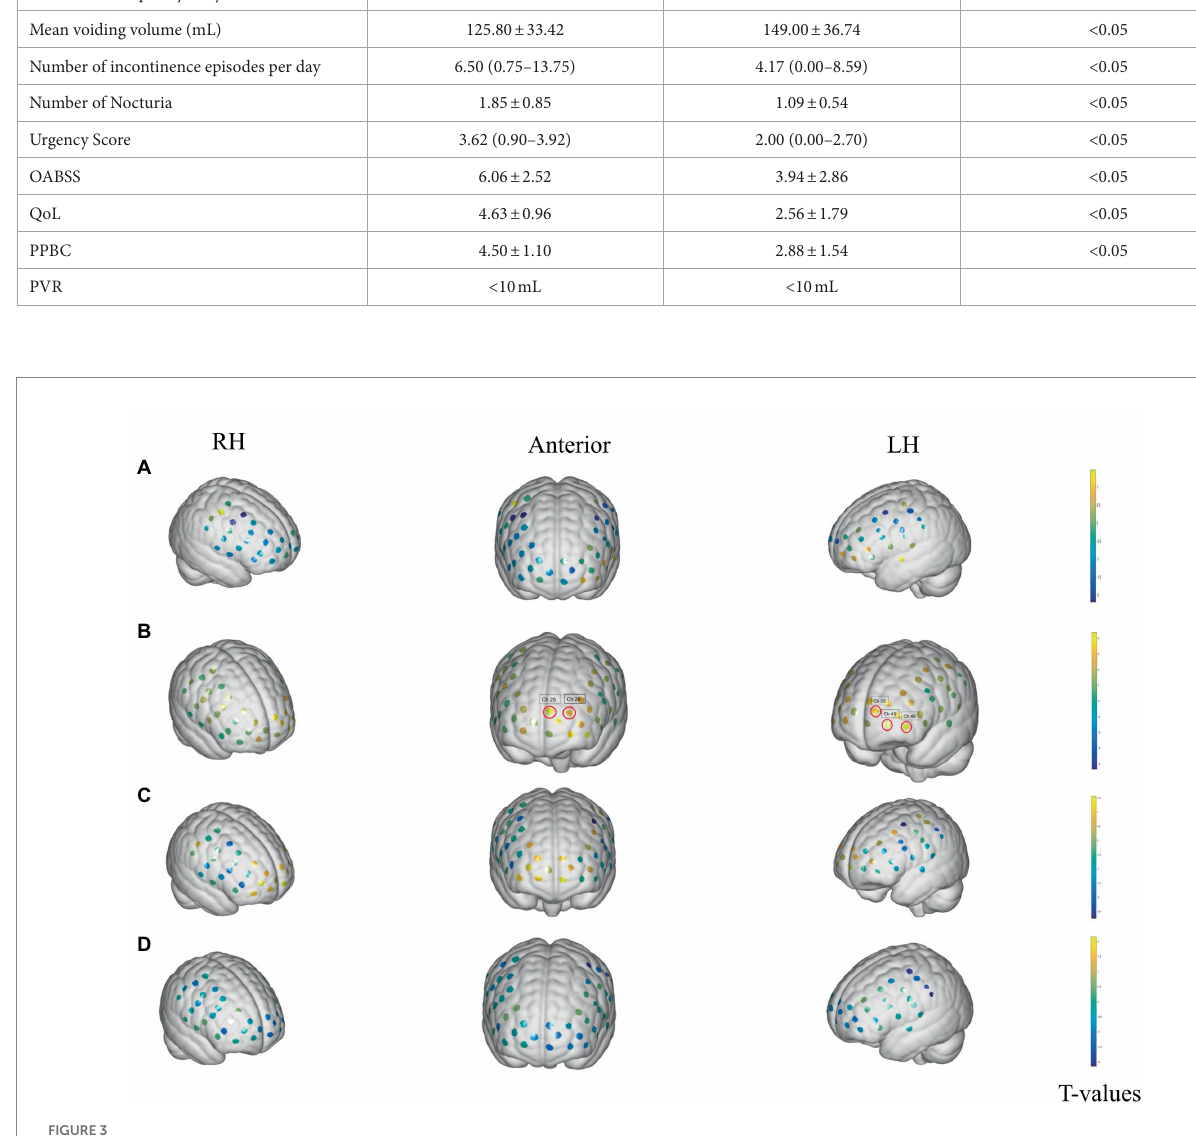
FIGURE 3 Activation changes of ROI fNIRS data in the empty-bladder and SDV states in successfully treated group. (A) Activation of sham stimulation state with empty bladder. (B) Activation of verum stimulation with empty bladder. (C) Activation of verum stimulation in SDV state. (D) Activation of sham stimulation in SDV state. The channels are denoted by the dots. Significance in activation variations is shown by red loops in front of channels ( p < 0.05, FDR corrected). The colored bar reflects group-level T -values. T The cool hue represents deactivation, whereas the bright color represents activation.